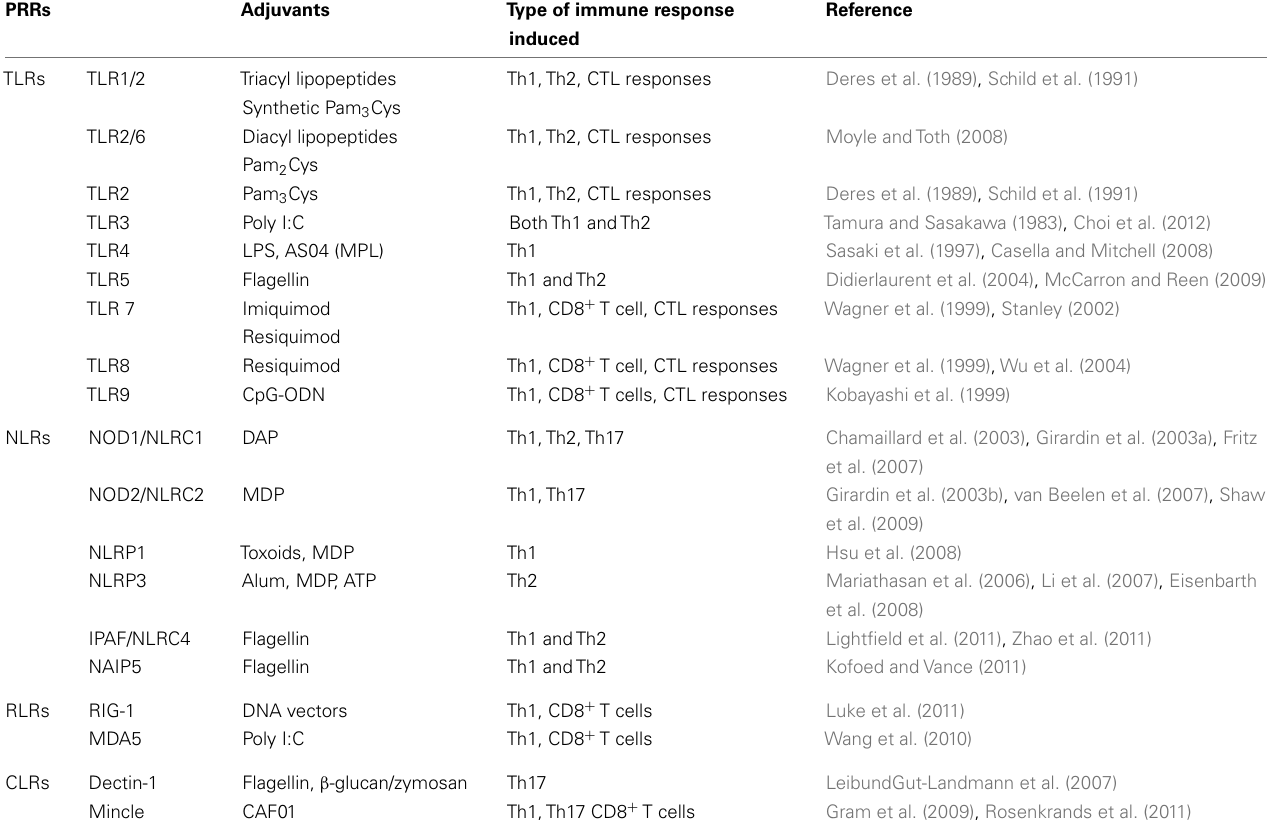
Table 2 | Innate immune receptors activated by vaccine